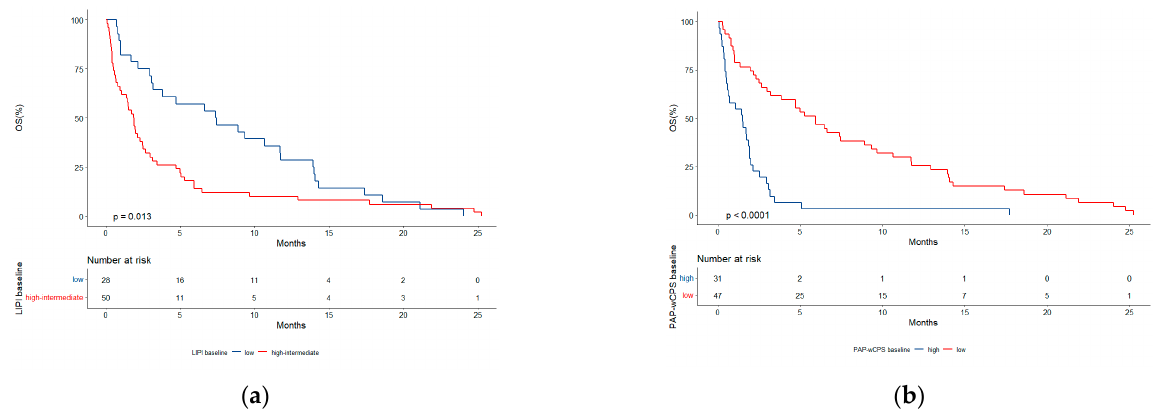
Figure 4. ( a ) Overall survival (OS) according to LIPI score; ( b ) OS according to PaPwCPS score.